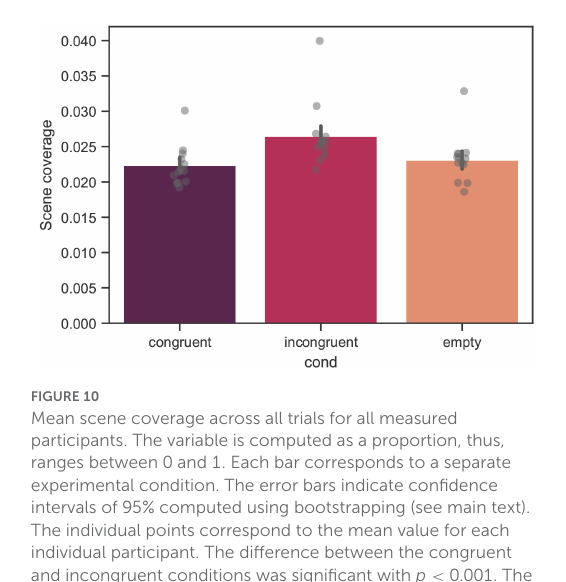
FIGURE10 Mean scene coverage across all trials for all measured participants. The variable is computed as a proportion, thus, ranges between 0 and 1. Each bar corresponds to a separate experimental condition. The error bars indicate confidence intervals of 95% computed using bootstrapping (see main text). The individual points correspond to the mean value for each individual participant. The difference between the congruent and incongruent conditions was significant with p < 0.001. The difference between the congruent and empty conditions was not